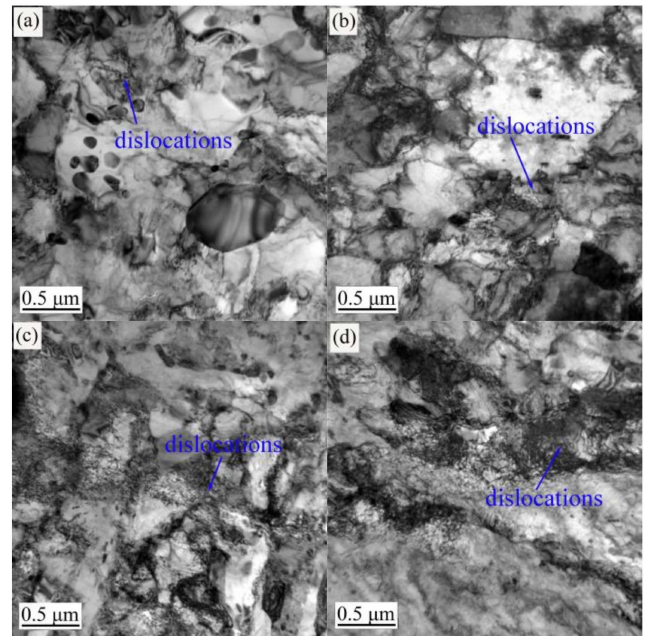
Figure 4. TEM observations of the 600 ◦ C-tempered AISI 420 steel after proton radiation with di ff erent